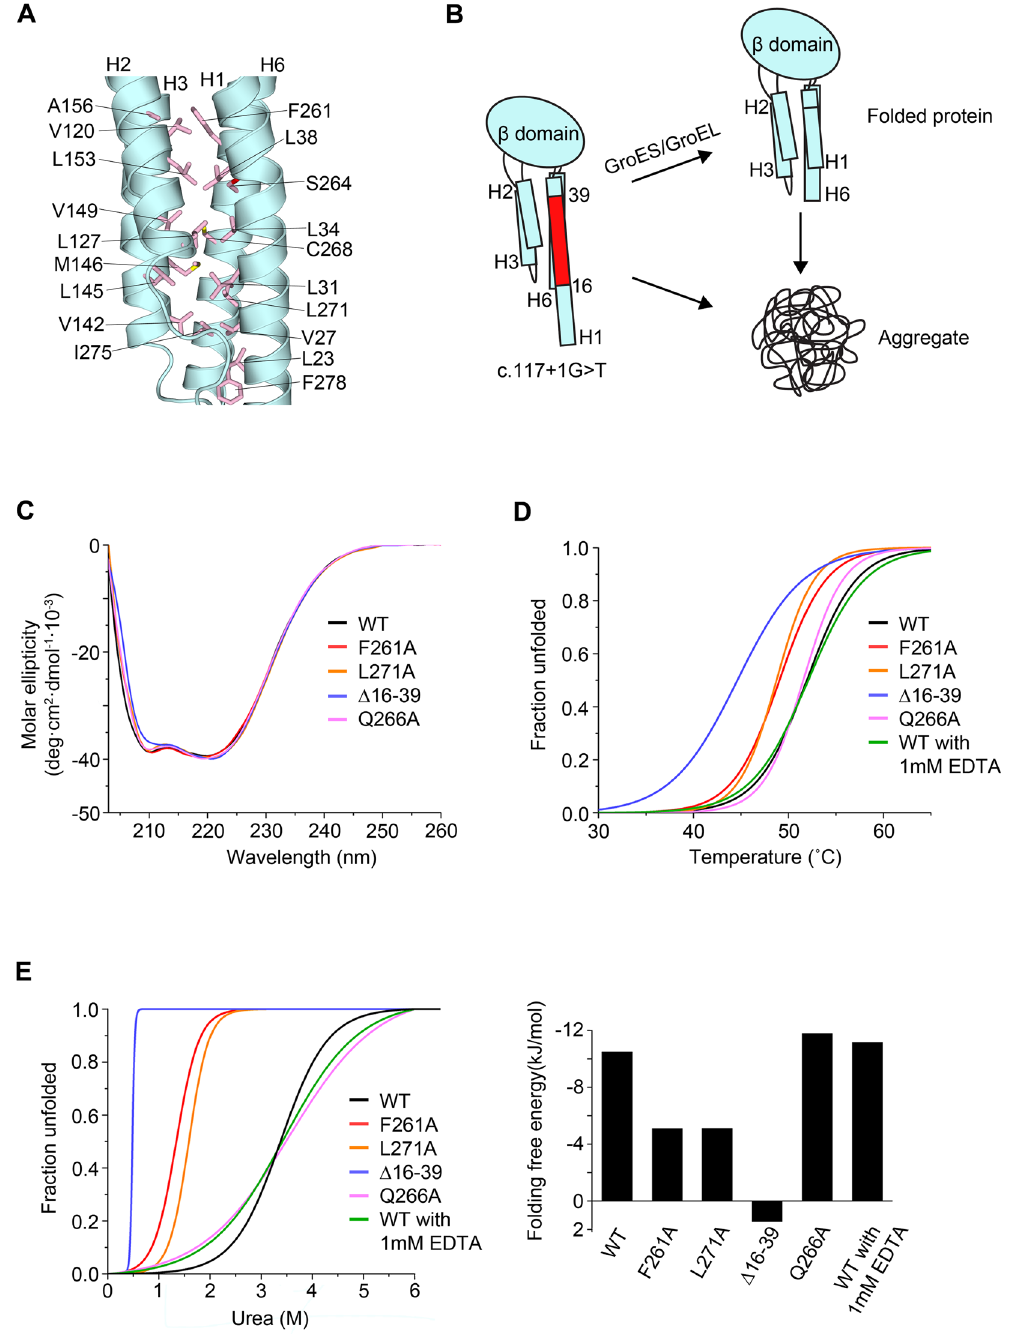
Figure 6. Mutation of Rogdi affects Structure and Stability. ( A ) Close-up view of the four-helix bundle hydrophobic interface in the α domain of Rogdi. ( B ) Schematic diagram showing the possible domain organization in the c. 117 + 1 G > T mutant 15 . The red region (residues 16–39) of H1 is deleted in the mutant due to a splicing error. ( C ) Far-UV CD spectra of wild-type and mutant Rogdi scanned from 203 to 260 nm. ( D ) Thermal unfolding curves of wild-type and mutant Rogdi measured by CD spectroscopy. ( E ) Urea-induced unfolding of wild-type and mutant Rogdi 39 conducted by monitoring loss of helicity during CD spectroscopy at 222